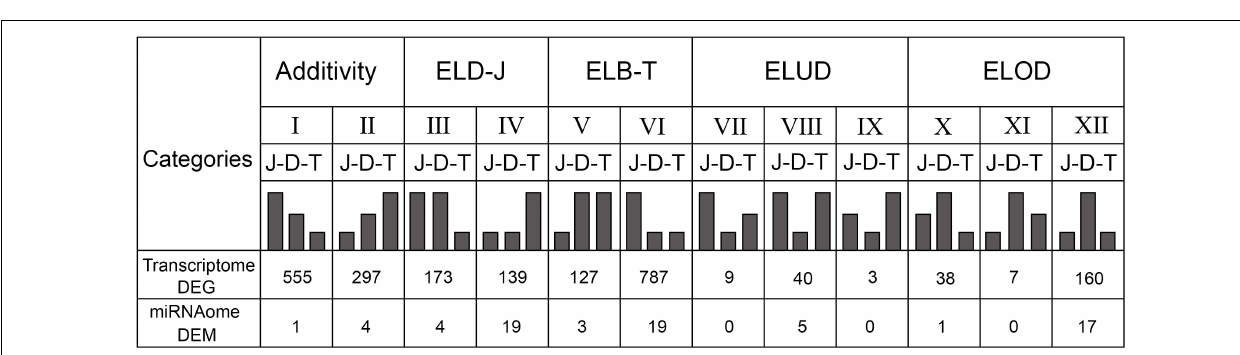
FIGURE 4 | Twelve differential expression patterns in the DEGs and DEMs between the hybrid abalone and its parents. ELD-J: expression level dominance by JP; ELD-T: expression level dominance by TW; ELUD: expression level underdominance; ELOD: expression level overdominance; J: JP; D: DY; T: